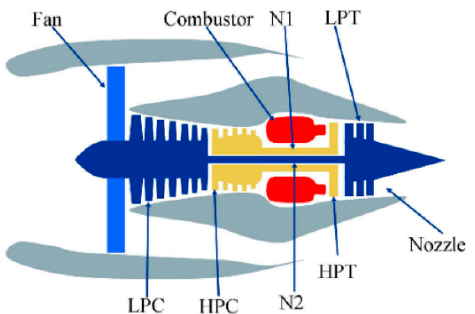
Figure 2. Simplified engine diagram in C-MAPSS [42]. Rotating modules: fan, low-pressure compressor (LPC), high-pressure compressor (HPC), high-pressure turbine (HPT), low-pressure turbine (LPT).